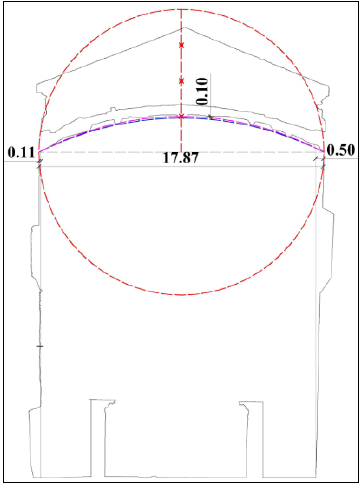
Figure 11. Measurements of collapses in vault 4 (values in